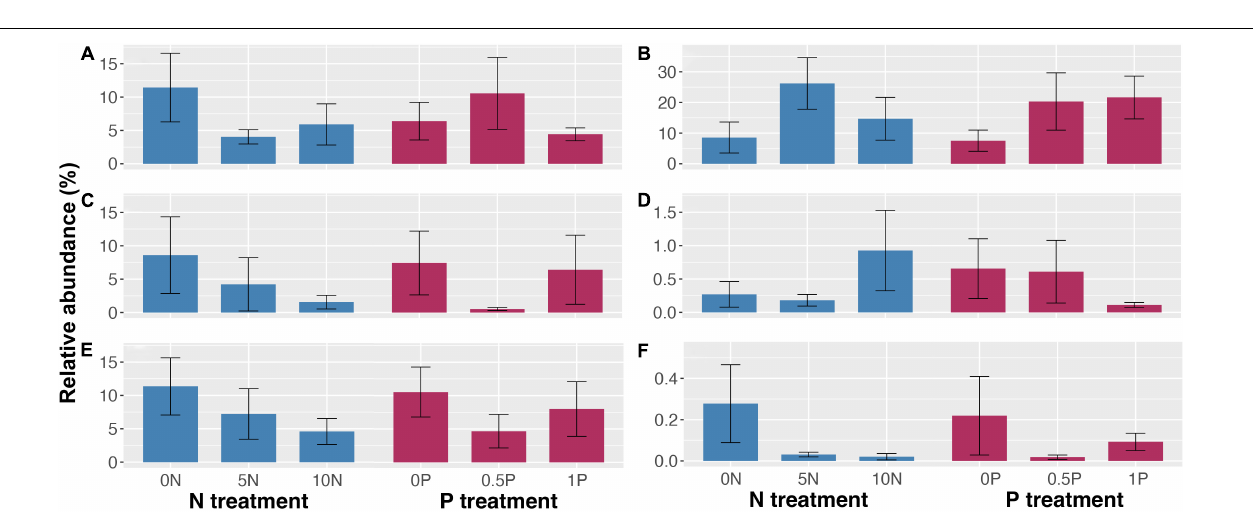
FIGURE 6 | Relative abundance (mean ± SE) of ericoid mycorrhizal fungi (A) , ectomycorrhizal fungi (B) , arbuscular mycorrhizal fungi (C) , lignocellulose-degrading fungi (D) , saprotrophic fungi (not including lignocellulose-degrading fungi) (E) , and Sphagnum -associated fungi (F) in response to long-term N and/or P additions. Treatment abbreviations as described in “Materials and Methods”